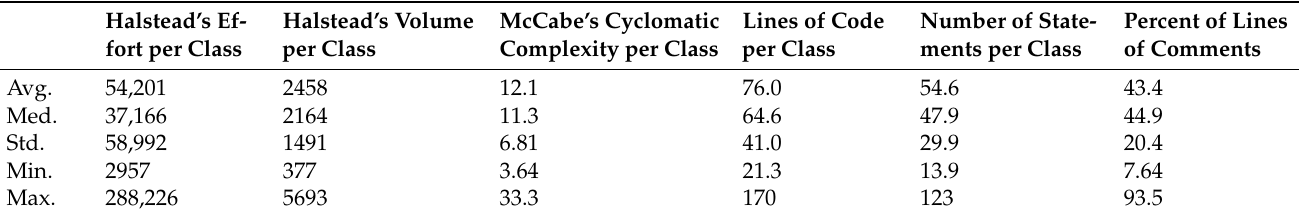
Table 6. Descriptive statistics of software metric values averaged per